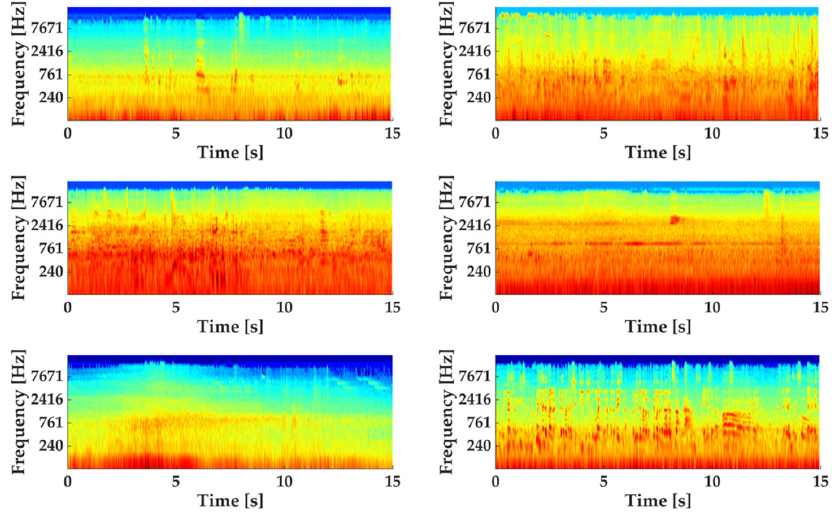
Figure 1. Log spectrograms of six examples from the set of stimuli used in the experiment.